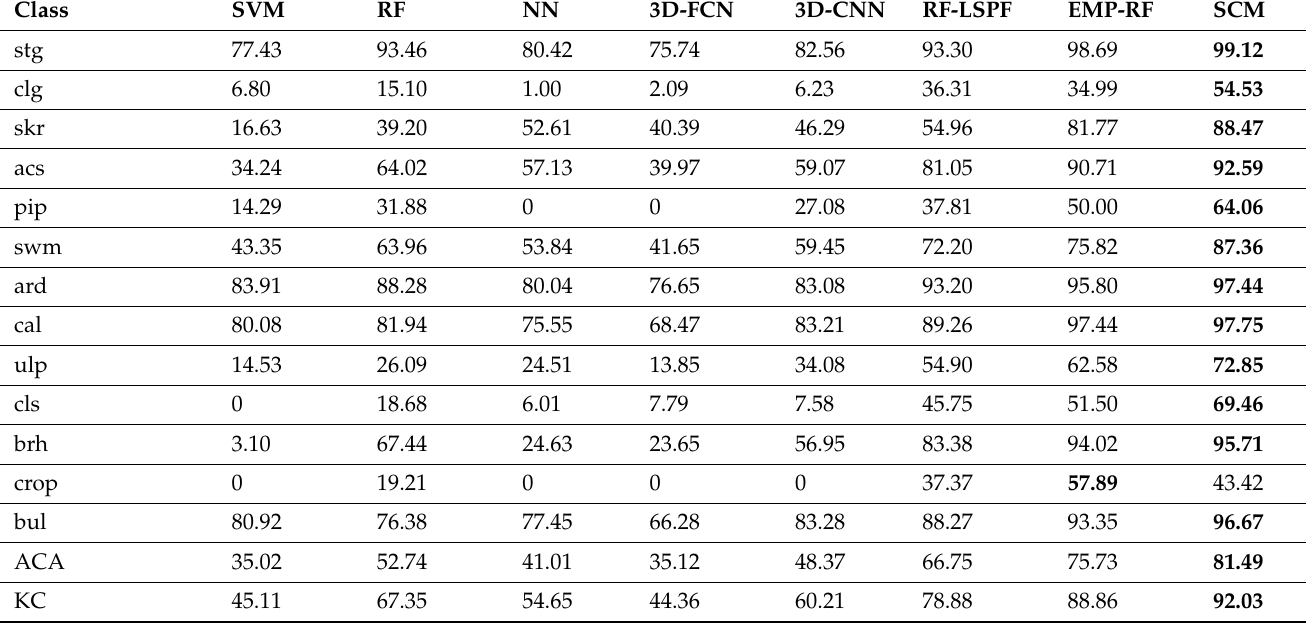
Table 3. Classification accuracy (%) of different methods for the Xilinhot